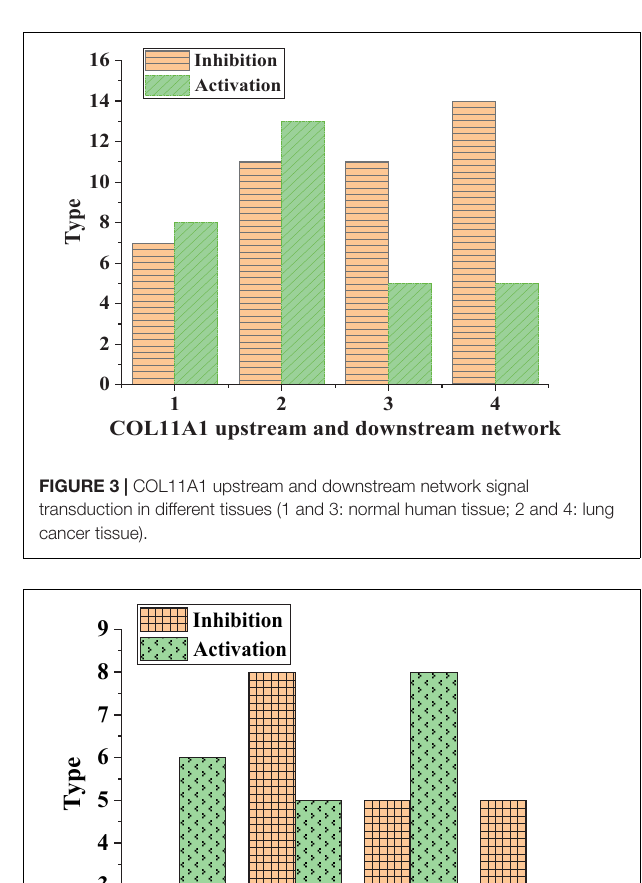
those in lung cancer tissues. In contrast, the types of metastatic molecules of activating COL11A1 in lung cancer tissues were more than those in normal tissues. This showed that COL11A1 was very metastatic in lung cancer